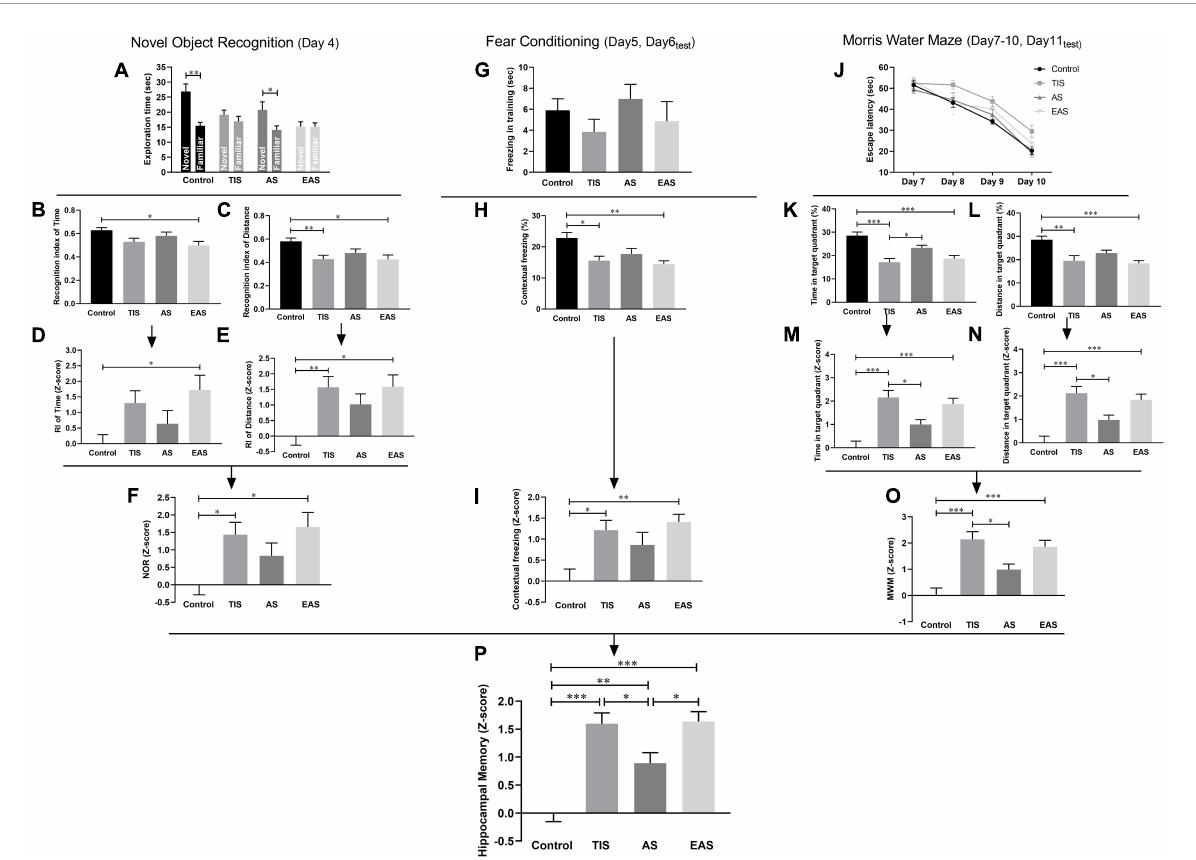
FIGURE5 Learning and memory behavior and Z-scores in the NOR, FC, and MWM. (A) Time mice spent exploring novel and familiar objects in the NOR test. (B) RI based on time. (C) RI based on distance. (D,E) Z-score normalization was performed with the same statistical results as before normalization. (F) NOR Z-scores were obtained by averaging the two index Z-scores. (G) Freezing time in the training phase of the FC test. (H) Contextual freezing time. (I) Normalization of data using the Z-score method was performed. (J) Escape latency in the MWM test. (K,L) Time and distance in the target quadrant. (M,N) Z-score normalization was performed with similar differences between groups as before normalization. (O) MWM Z-scores were obtained by averaging the two ratio Z-scores. (P) Hippocampus-dependent memory Z-score calculated by averaging the Z-scores of NOR, FC, and MWM. One-way ANOVA followed Bonferroni’s post hoc test. Data represent mean ± SEM ( n = 9–12 per group). ∗ P < 0.05; ∗∗ P < 0.01; ∗∗∗ P < 0.001.